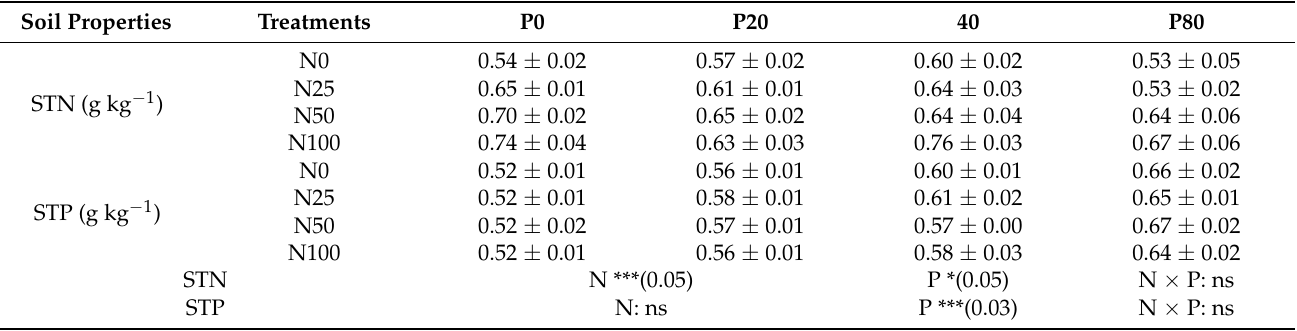
Table 1. Soil total nitrogen (STN) and soil total phosphorus (STP) of the grassland under different N and P additions (mean ± s.e.; n = 3). * p < 0.05; ** p < 0.01; *** p < 0.001.